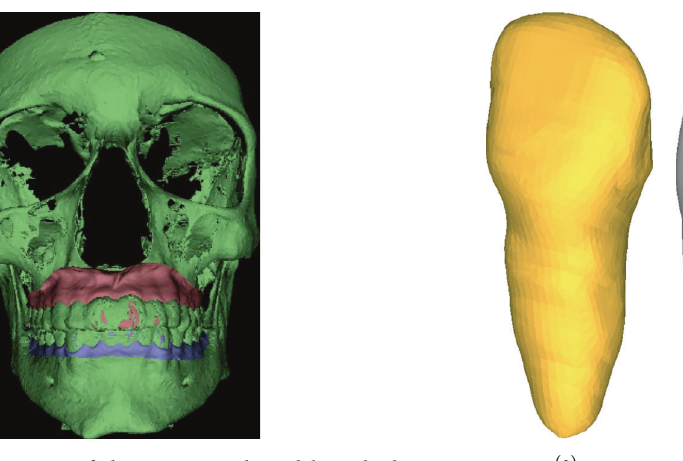
Figure 4: Superimposition of the 3D-scanned models with the CBCT to find the threshold value.